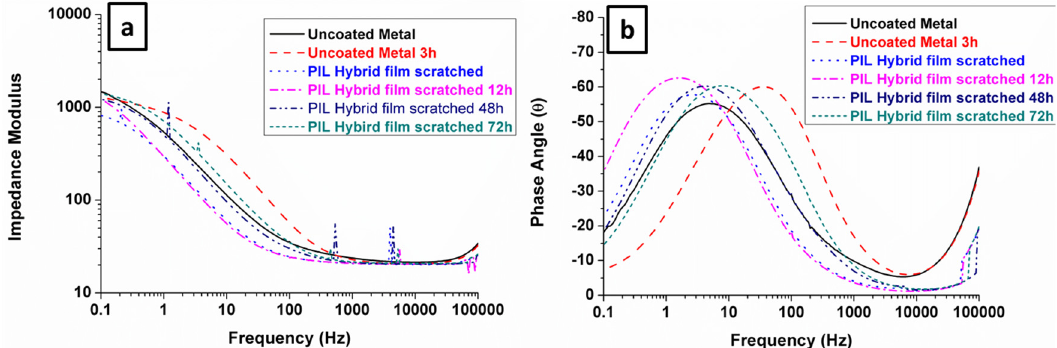
Figure 11. ( a ) Bode plot; ( b ) phase angle of the impedance of a scratched PIL hybrid film/SNAP coated sample over 72 h compared with uncoated metal samples.